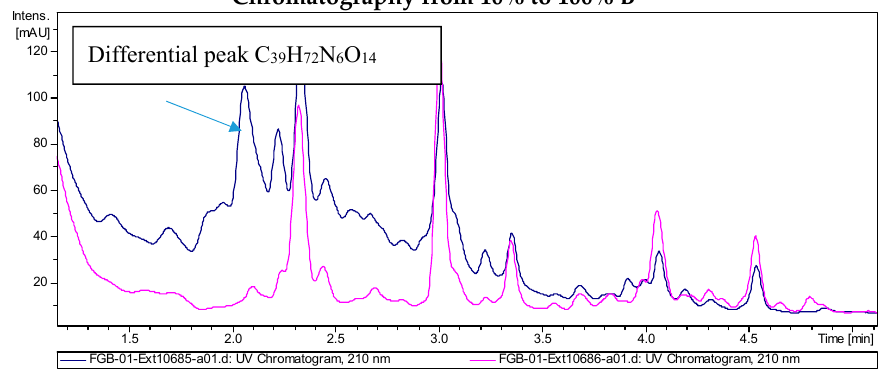
Figure 2. Chromatograms of the extract from S. albus PVA94-07 carrying an empty vector (pink) and S. albus PVA94-07 overexpressing the c10A regulatory gene (blue). Differential peaks and molecular formulae for the corresponding compounds are indicated.